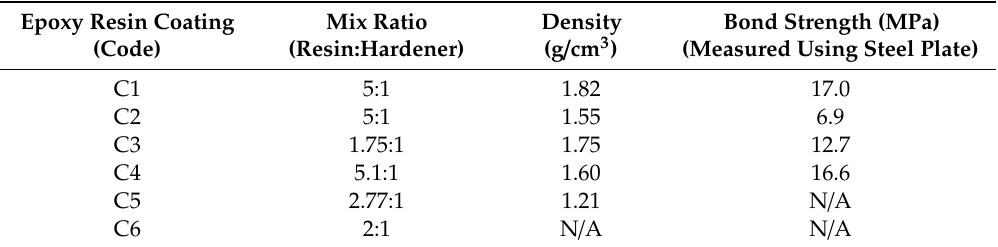
Table 1. Material properties of the selected commercial epoxy resin coatings. Epoxy Resin Coating Mix (Code)